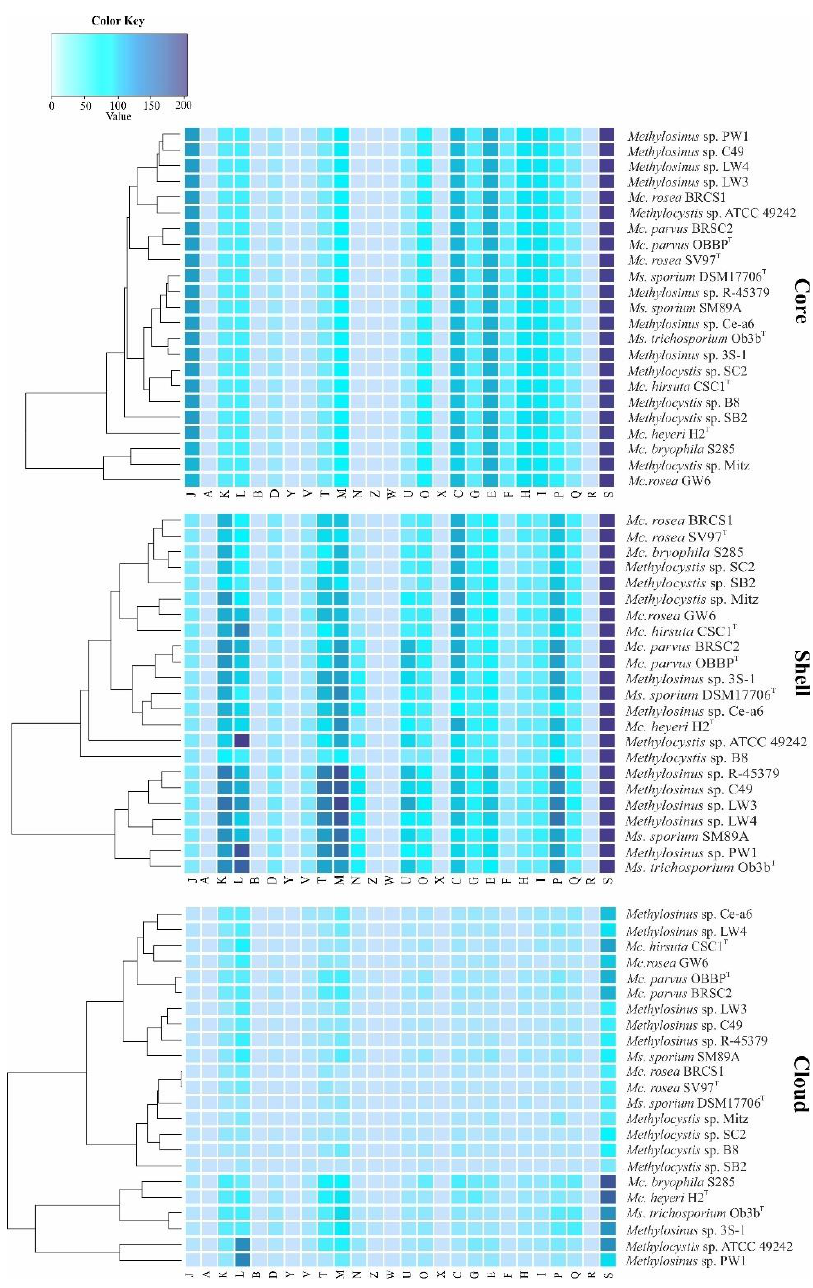
Figure 4. Functional annotation of core, shell, and cloud genes against COG database. Genes were automatically assigned to the following COG categories: A, RNA processing and modification; B, chromatin structure and dynamics; C, energy production and conversion; D, cell cycle control and mitosis; E, amino acid metabolism and transport; F, nucleotide metabolism and transport; G, carbohydrate metabolism and transport; H, coenzyme metabolism, I, lipid metabolism; J, translation; K, transcription; L, replication and repair; M, cell wall/membrane/envelop biogenesis; N, cell motility; O, post-translational modification, protein turnover, chaperone functions; P, inorganic ion transport and metabolism; Q, secondary structure; T, signal transduction; U, intracellular trafficking and secretion; Y, nuclear structure; V, defense mechanisms; Z, cytoskeleton; W, extracellular structures; X, mobilome: prophages, transposons; R, general functional prediction only; S, function unknown. The color key reflects the total number of genes in each COG category.